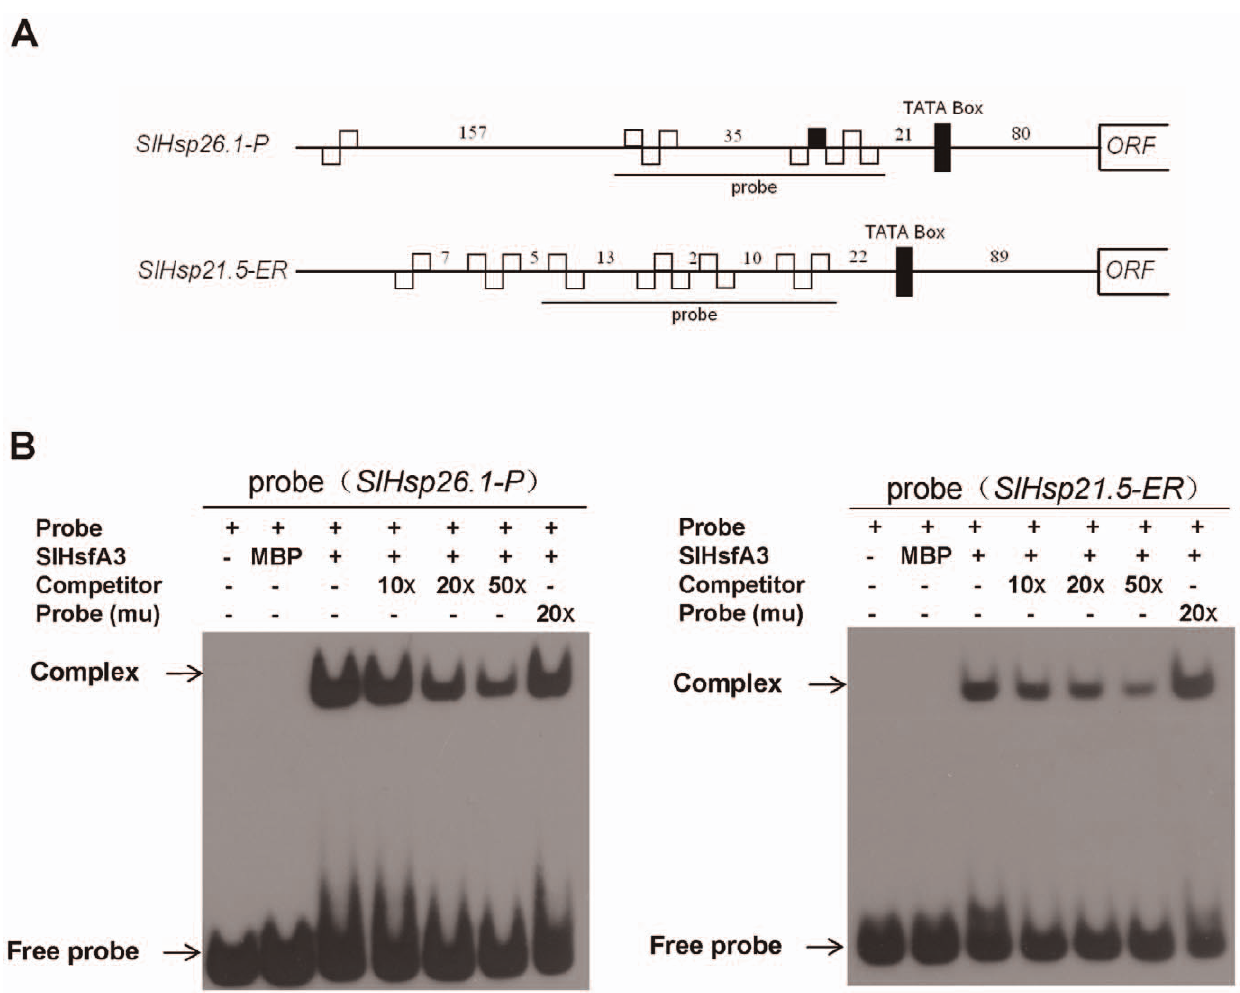
Figure 8. SlHsfA3 directly binds to the promoter regions of SlHsp26.1-P and SlHsp21.5-ER . (A) Illustration of the SlHsp26.1-P and SlHsp21.5- ER promoter regions showing the presence of HSEs DNA motifs. HSEs are drawn according to the nomenclature of Nover et al . (2001) [3]. Numbers in between indicate the distance in bp. The TATA box is also indicated in the schematic diagram. (B) EMSA assays showing that SlHsfA3 binds the HSEs motifs present in the SlHsp26.1-P and SlHsp21.5-ER promoters in vitro . SlHsfA3-MBP recombinant protein was expressed in E. coli cells. The corresponding probes were indicated in (A) and labeled with biotin. Competition for SlHsfA3 binding was performed with 10X, 20X and 50X cold unlabeled probes and 20X mutated probes. For details see Materials and methods. (Fig. 3A). The SlHsfA3 pro : GUS cassette was stably transformed into Arabidopsis . Histochemical staining of transgenic plants exhibited GUS activity at almost all developmental stages. In 6-d-old seedlings grown under normal conditions, the GUS signal was relatively weak throughout the plants with almost undetectable GUS activity in roots (Fig. 3B). However, increased